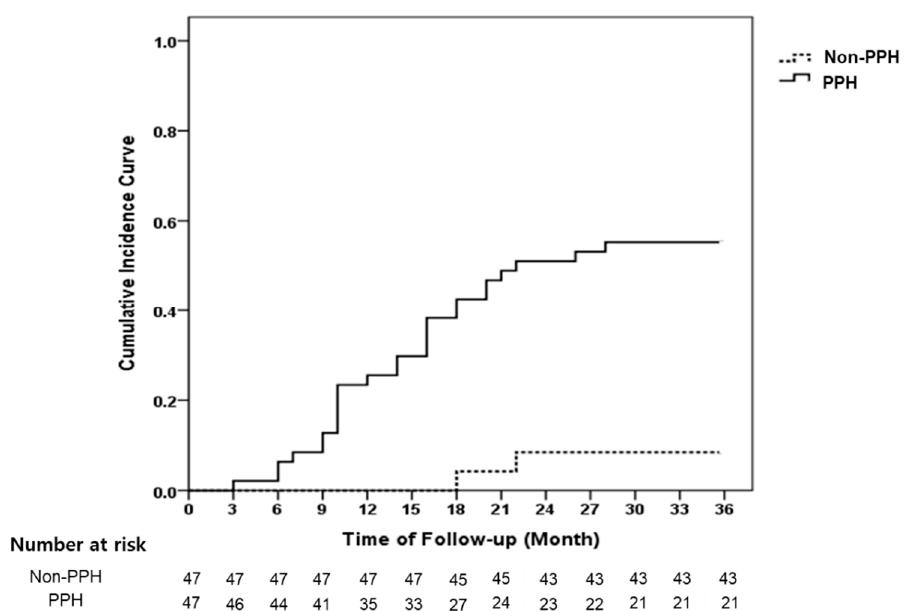
Figure 1. Kaplan–Meier curve of the incidence of new CVD between participants with and without PPH at baseline. The 3 year incidence of CVD was significantly higher in the group with PPH than in the group without PPH at baseline (55.3% vs. 8.5%, log-rank test, p < 0.001). PPH, postprandial hypotension; CVD, cardiovascular disease.